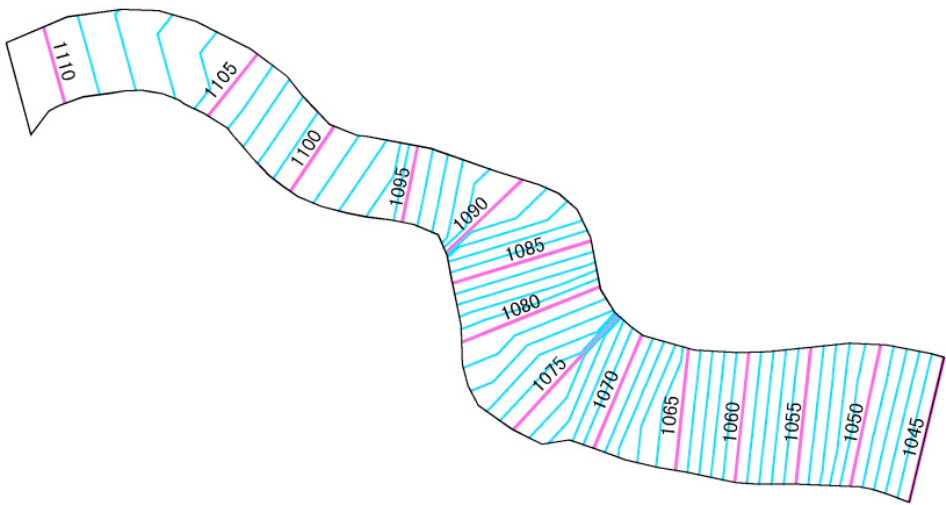
Figure 4. Examples of ski track contour lines of WTST. The 1-meter contour lines will be distorted and uneven on the snow track surface in certain situations, which requires optimization. In practice, manual adjustment of contour lines is always time-consuming. The constructors wanted contour lines that were perpendicular to the centerline and as even as possible (see Figure 5). Based on the experience of the construction of the National Alpine Skiing Center of the 2022 Beijing Olympic Games, a method combining mathematics and computer science with three steps is proposed: (1) to set the point with a 1 m contour distance on the centerline; (2) generate a perpendicular line of the centerline based on the point set based on step 2; (3) increase the ski track cross slope.